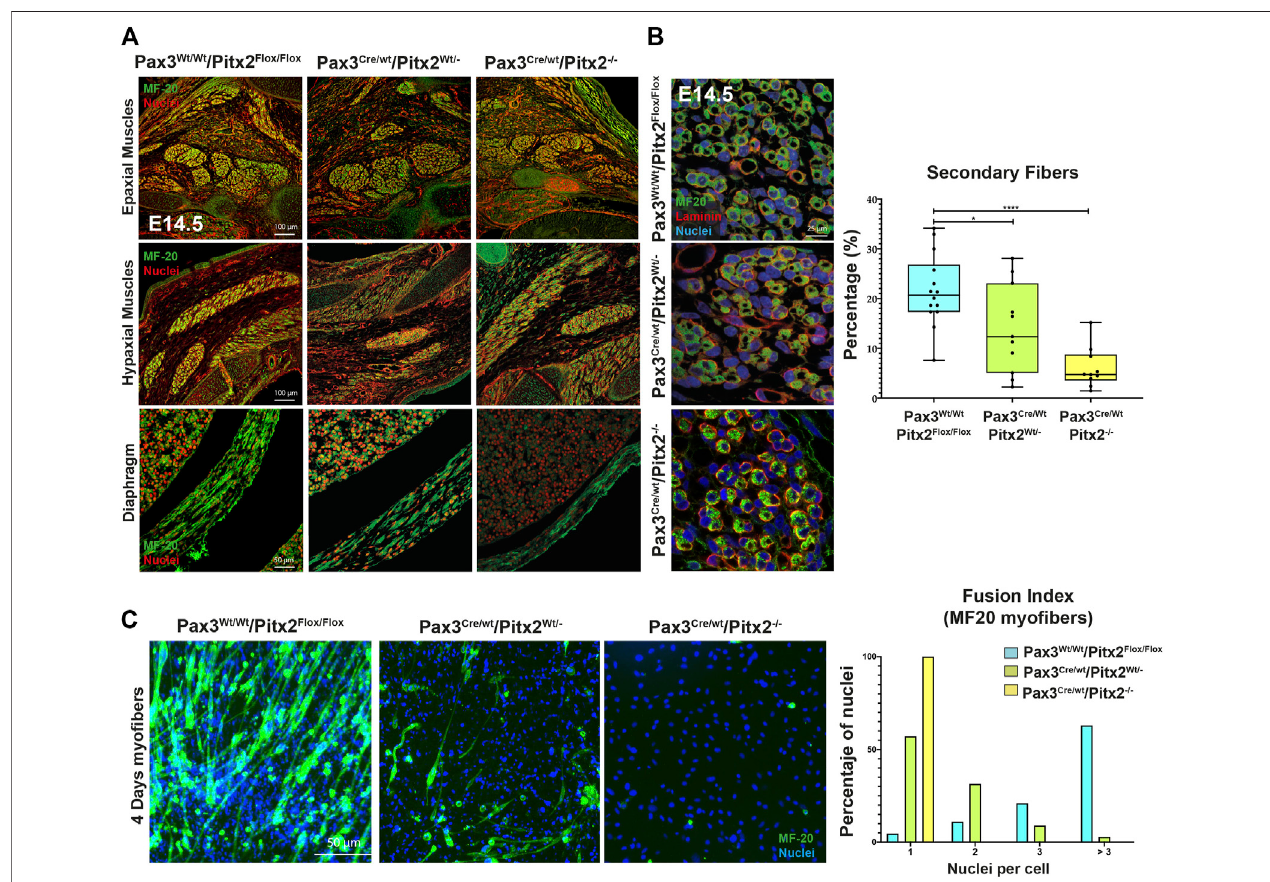
FIGURE 4 | At fetal stages Pax3 Cre/Wt /Pitx2 − / − mutants display muscle hypotrophy together with altered secondary myogenesis and myoblasts differentiation. (A) Representative images of MF20 immunostaining in Epaxial, Hypaxial muscles and diaphragm in Pax3 Wt/Wt /Pitx2 Flox/Flox , Pax3 Cre/Wt /Pitx2 Wt/- and Pax3 Cre/Wt /Pitx2 − / − embryoat E14.5stage. (B) Representativeimages ofMF20 and Laminin immunostaininginPax3 Wt/Wt /Pitx2 Flox/Flox ,Pax3 Cre/Wt /Pitx2 Wt/- and Pax3 Cre/Wt /Pitx2 − / − embryo at E14.5 stage. Percentage of secondary myotubes is shown. (C) Representative images of cultured myoblasts isolated from the limbs of E18.5 Pax3 Wt/Wt / Pitx2 Flox/Flox ,Pax3 Cre/Wt /Pitx2 Wt/- and Pax3 Cre/Wt /Pitx2 − / − embryos stainedwithanti-MHCantibody.Quanti fi cation ofindex fusionisshown.* p < 0.1,*** p < 0.001 ( n =at least 3 embryos per